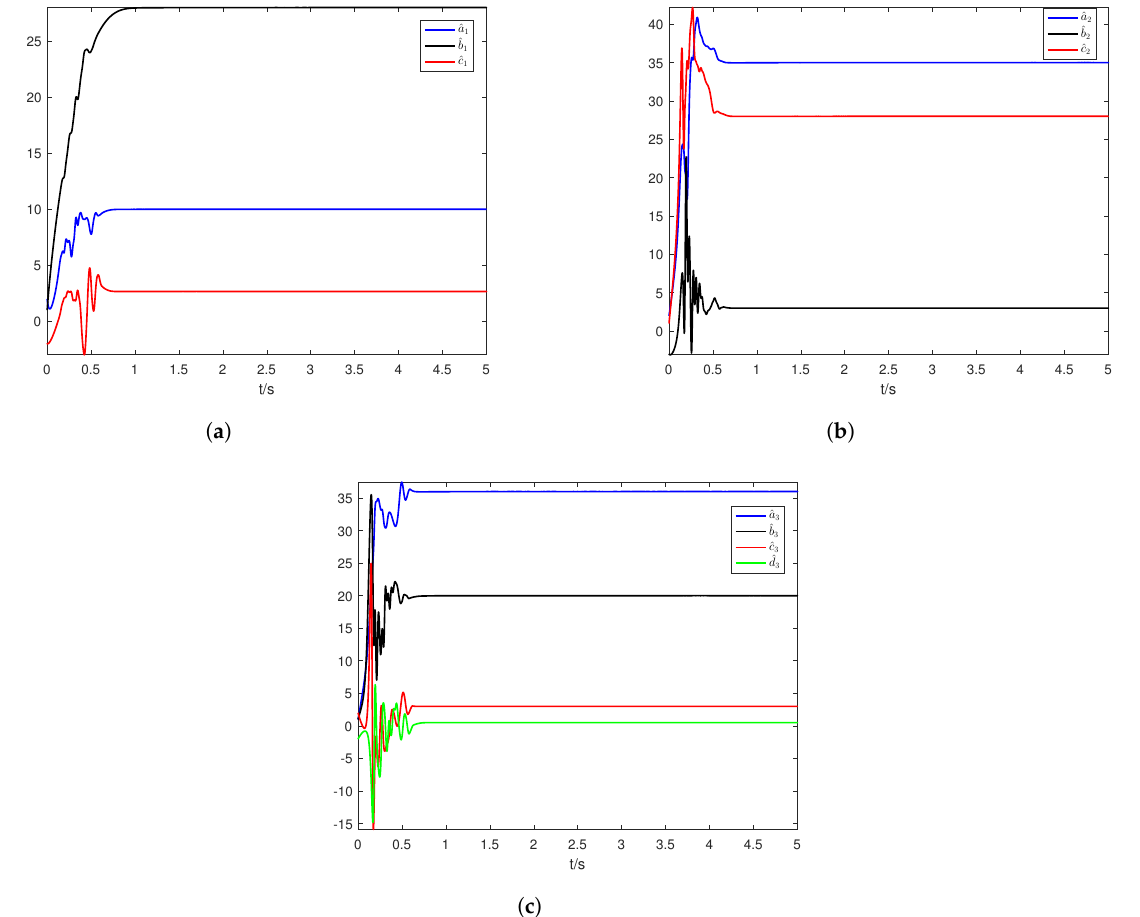
Figure 13. The estimation of parameters ˆ a 1 , ˆ b 1 , ˆ c 1 of drive system (43) ( a ), ˆ a 2 , ˆ b 2 , ˆ c 2 of drive system (44) ( b ), ˆ a 3 , ˆ b 3 , ˆ c 3 , ˆ d 3 of drive system (45) ( c ).